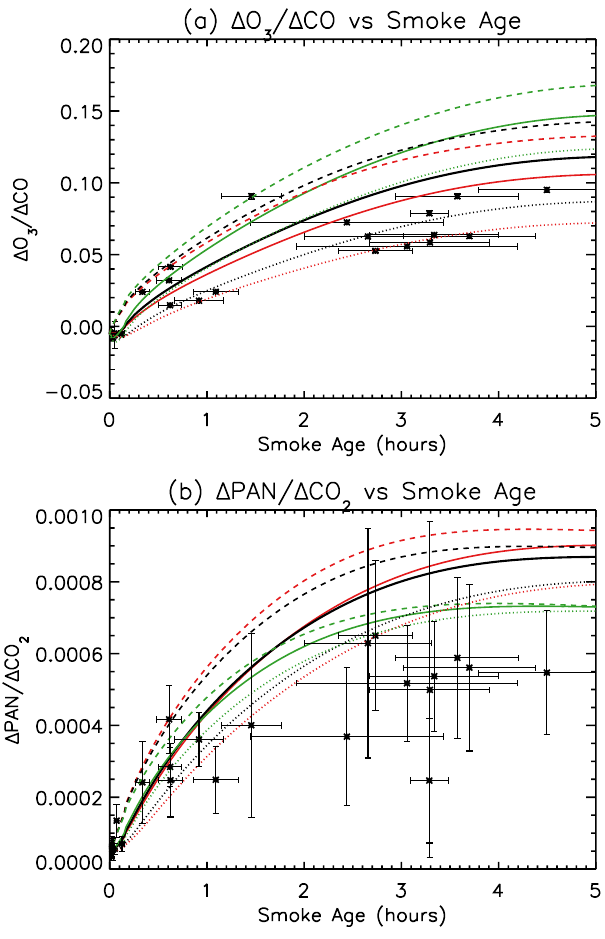
Figure 13. As in Fig. 5, but for the optimized SVOC chemistry (see Table